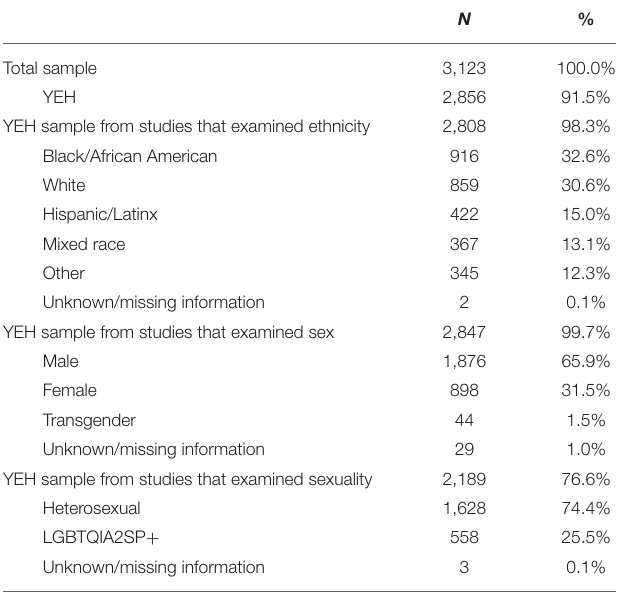
TABLE 2 | YEH’s reasons for using N %